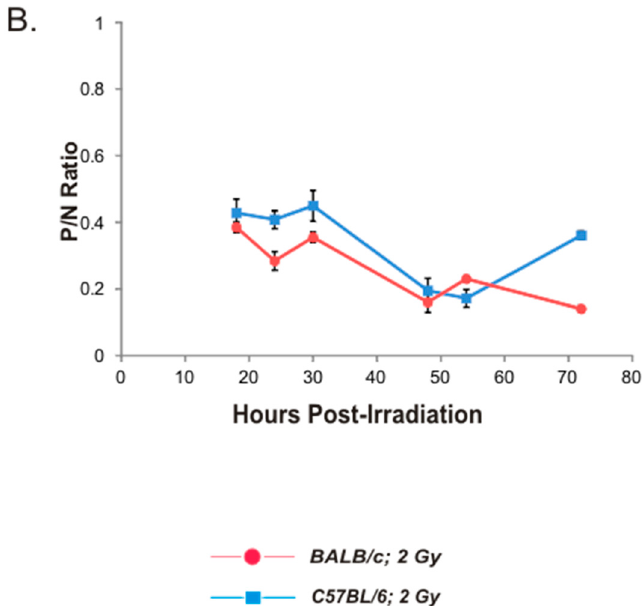
Figure 3. Time course analysis of MN-PCE frequencies and P / N ratios in mouse bone marrow following 2 Gy radiation exposure: Bone marrow MN-PCE frequencies ( A ) and P / N ratios ( B ) following 2 Gy irradiation of C57BL/6 (blue square symbols) or BALB/c (red circle symbols) mice. Data points represent the mean value of pooled samples; error bars indicate standard error. For C57BL/6 data analysis, six animals were sampled per treatment group, with the exception of the 24 h time point group comprised of 18 animals for MN-PCE analysis (reproduced from Figure 2) and 15 animals for P / N ratio determination (reproduced from Figure 2). For BALB/c data analysis, two animals were sampled per treatment group, with the exception of the 24 h time point group comprised of seven animals for MN-PCE analysis (reproduced from Figure 2) and five animals for P / N ratio determination (reproduced from Figure 2). Statistical analysis comparing C57BL/6 and BALB/c treatment cohort samples was not performed due to limited number of BALB/c samples for the majority of time points.